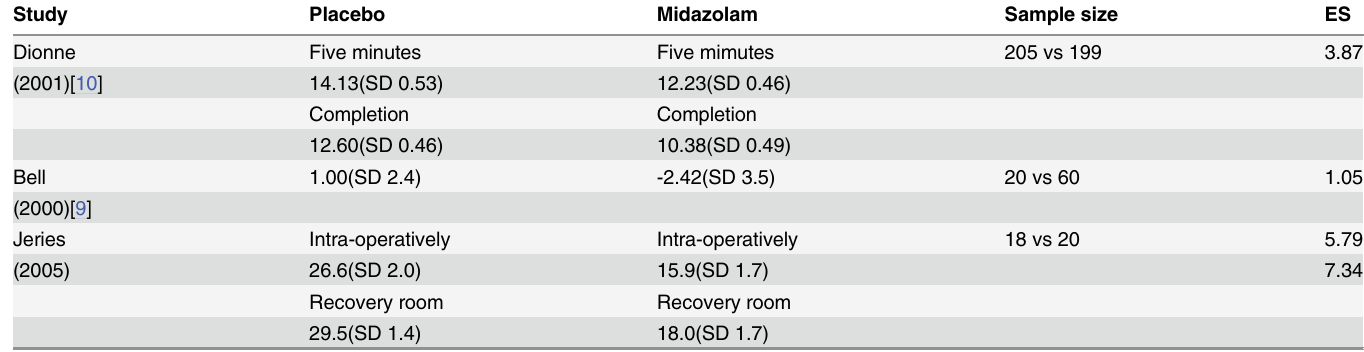
Table 3. Midazolam anti-anxiety compared with